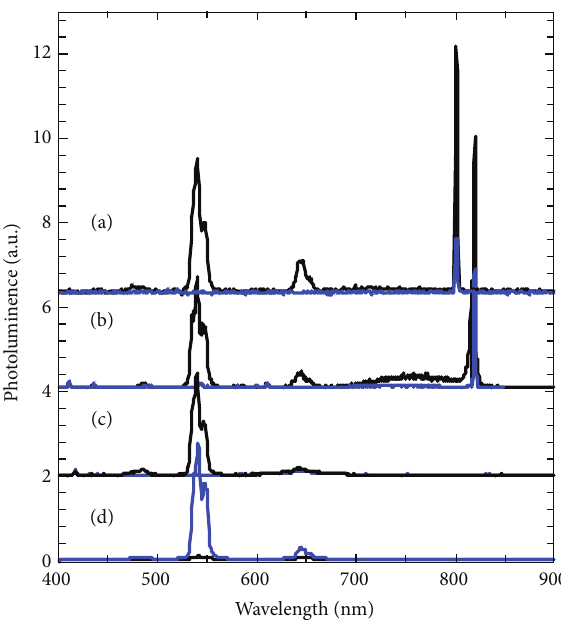
Figure 7: Demonstration of dye-induced upconversion of NaYF 4 nanoparticles doped with Yb 3+ sensitizer and holmium activator (NaY 0.78 Yb 0.20 Ho 0.02 F 4 ). Plots (a), (b), and (c) show the emission for excitation at 801 nm, 819 nm, and 832 nm, respectively, where the attached DY-831 infrared dye absorbs, but where the Yb 3+ sensitizer does not. Characteristic Ho 3+ upconversion is seen in plot (d) for excitation at 975 nm. Ho 3+ upconversion is seen in plots (a), (b), and (c) for the dye-attached nanoparticles (black curves), while none is seen for the control nanoparticles without attached dye (blue